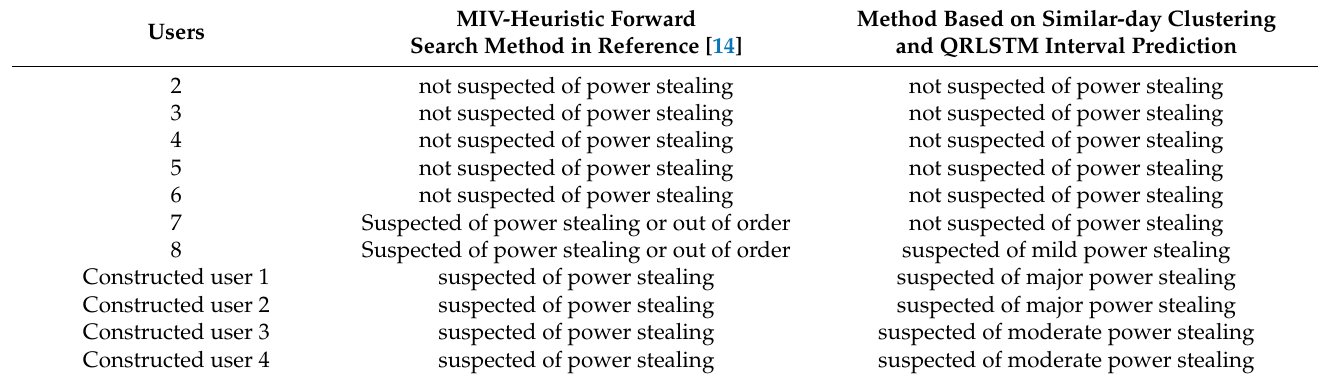
Table 6. Comparison of identification results of two